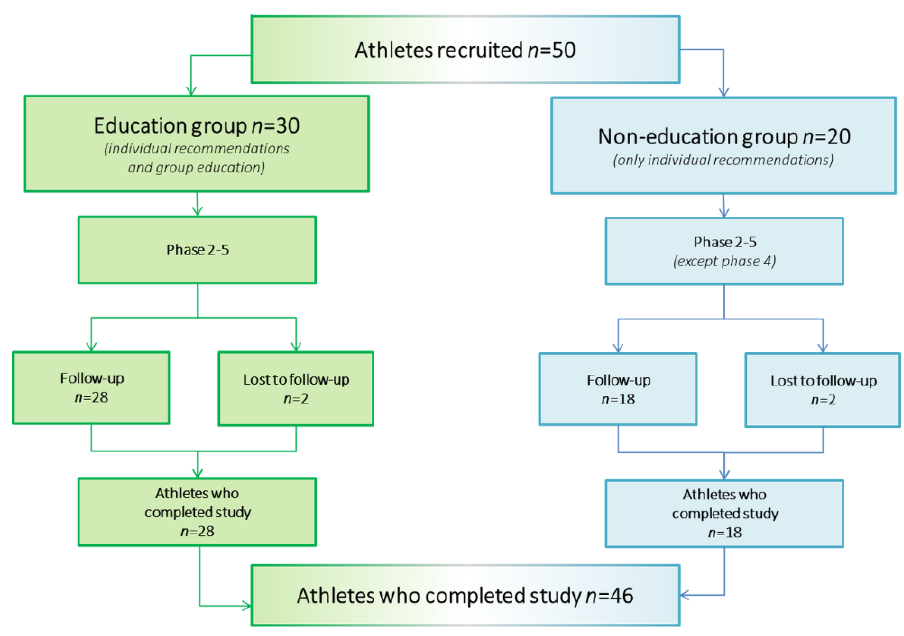
Figure 1. Flowchart of the follow-up process.